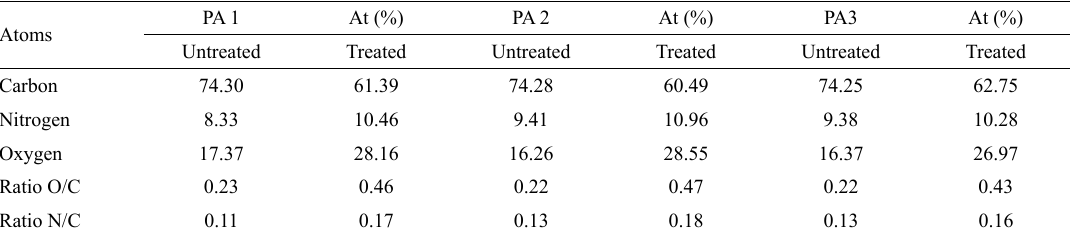
Table 5. XPS Results of the polyamide samples with and without plasma treatment (2.5 kW.min.m -2 ). PA Atoms